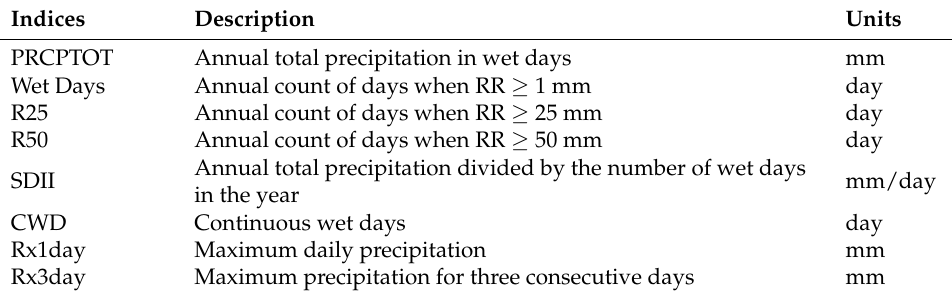
Table 2. Definitions of the 8 selected extreme precipitation